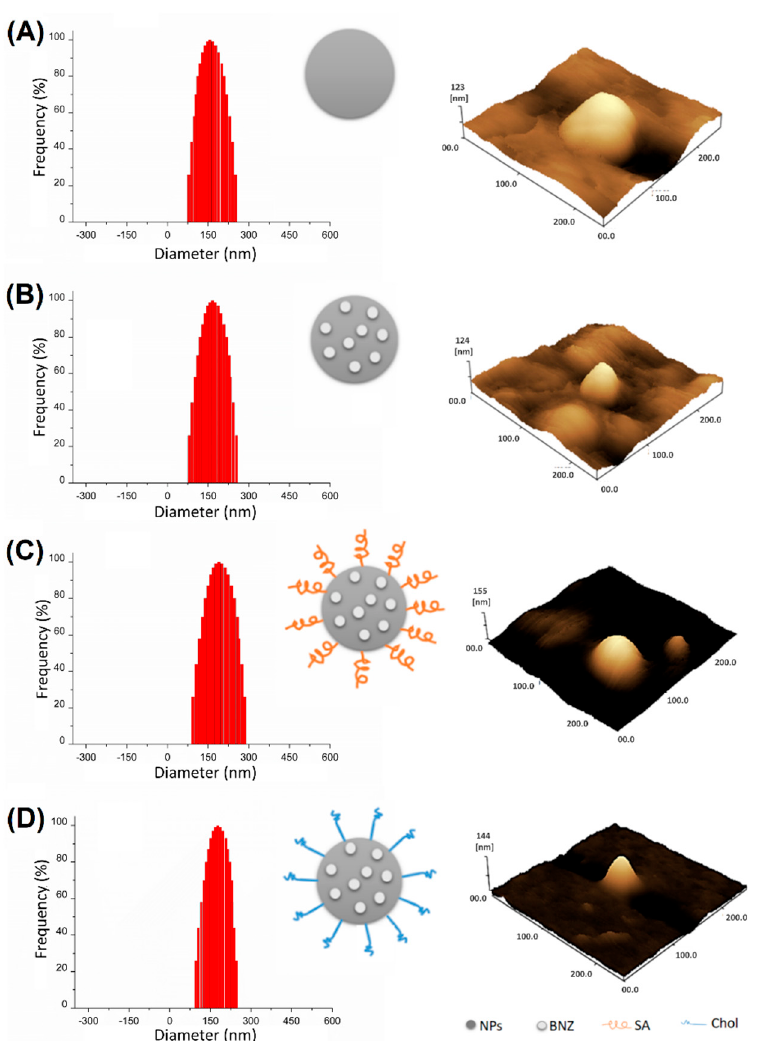
Figure 1. Particle size distribution (left) and 3D AFM images (right) of ( A ) NPs; ( B ) NP BNZ; ( C ) NP BNZ SA; and ( D ) NP BNZ Chol.